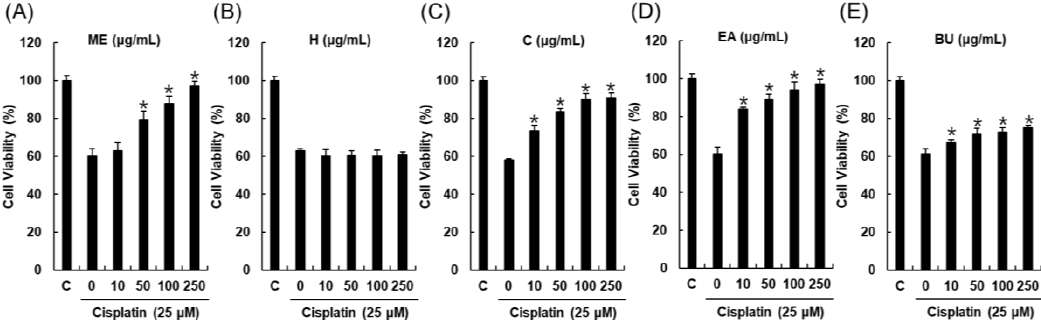
Figure 1. Protective effects of the MeOH extract (ME) of Streptomyces sp. RB1 and its fractions (hexane-soluble (H), CH 2 Cl 2 -soluble (C), EtOAc-soluble (EA), and n -BuOH-soluble fractions (BU)) in LLC-PK1 cells exposed to 25 μM of cisplatin for 24 h by MTT assay. Protective effects of ( A ) ME, and ( B ) H fraction, ( C ) C fraction, ( D ) EA fraction, and ( E ) BU fraction in LLC-PK1 cells exposed to 25 μM of cisplatin for 24 h by MTT assay. The concentrations of samples were 0, 10, 50, 100 and 250 µ g/mL. Control cells were treated with the vehicle only (mean ± SD, * p < 0.05 compared to the